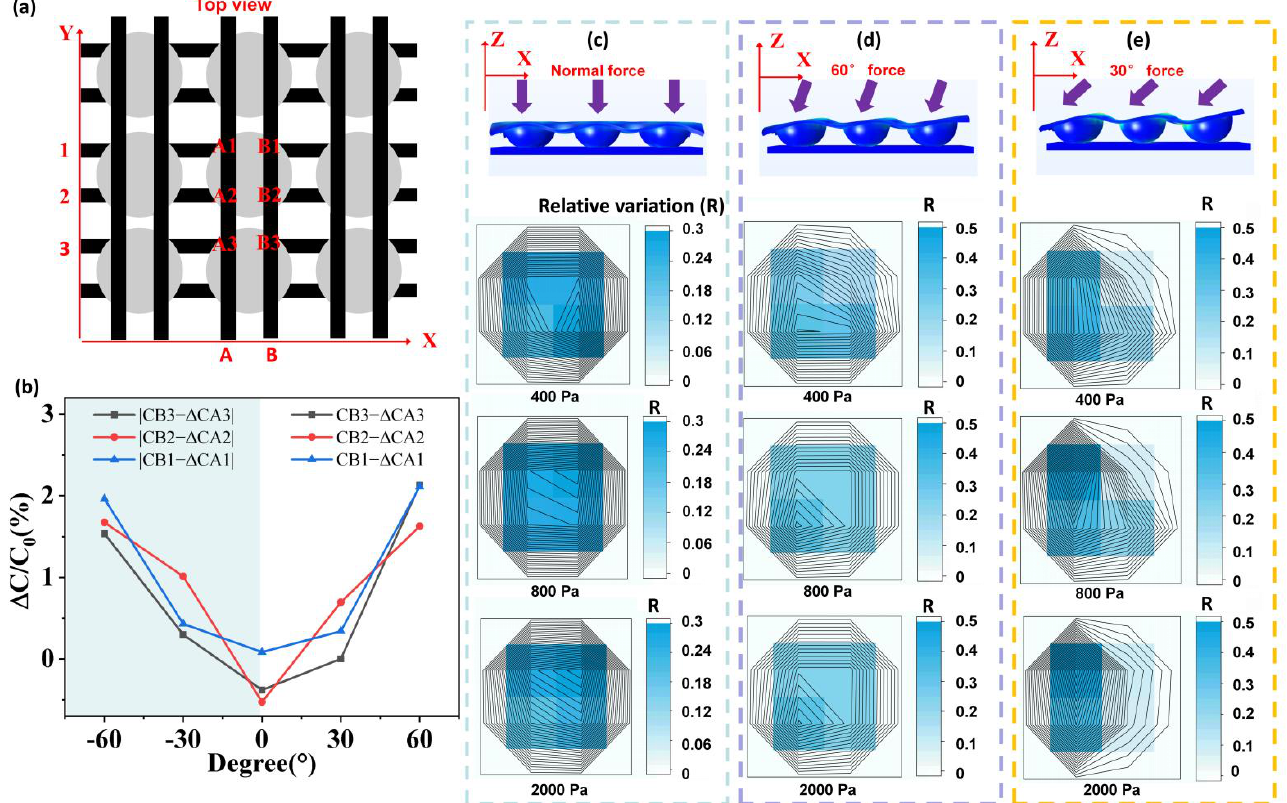
Figure 4. Representation of forces in different directions by ODT sensors. ( a ) Schematic diagram of electrode distribution set to be measured and characterized. ( b ) The difference of capacitance variation of adjacent units corresponding to 2 KPa pressure inclined along XoZ plane at different angles. ( c – e ) Top: Cross-sectional views with forces shown in arrows (normally, 60° and 30° incline, respectively). Below: Top views of the relative changes in capacitance shown for capacitors applied by different directional forces with the pressure at 400 Pa/800 Pa/2000 Pa.